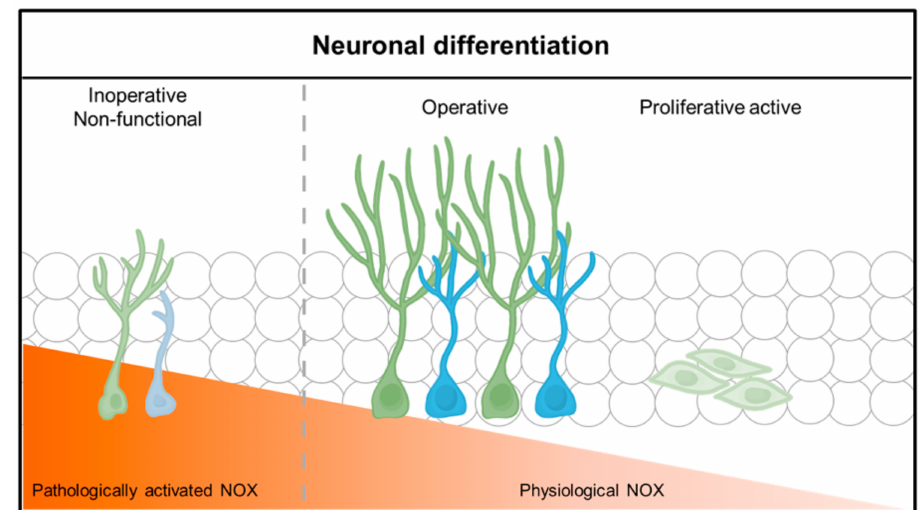
Figure 2. Neuronal differentiation and function according to physiological NADPH oxidase (NOX) activity. Neuronal stem cells (NSCs) differentiate and function into neurons in a physiological or low NADPH oxidase environment. NOX in a physiological state causes lineage differentiation of neuronal stem cells (NSCs), but, under pathological conditions, neuronal stem cells (NSCs) do not differentiate well into neurons or function